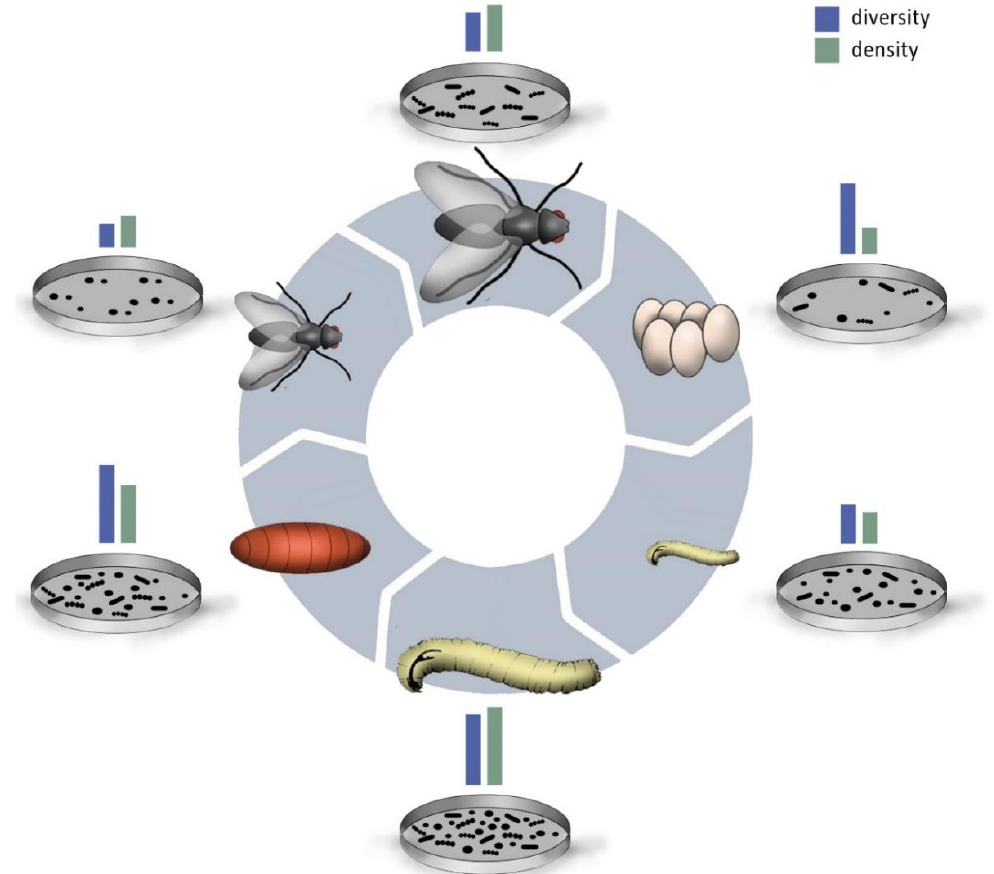
Figure 2. Schematic representation of the changes in gut bacterial density and diversity over the course of the life cycle including egg, larval, pupal, and adult life stages that is based on the current literature reporting on seven species (Table S1). In green: relative gut bacterial community (GBC) density, in blue: relative GBC diversity. Relative changes in gut bacterial diversity and densities are represented by the different shapes and numbers of microbes in a Petri dish. (Picture: Jennifer Gabriel).